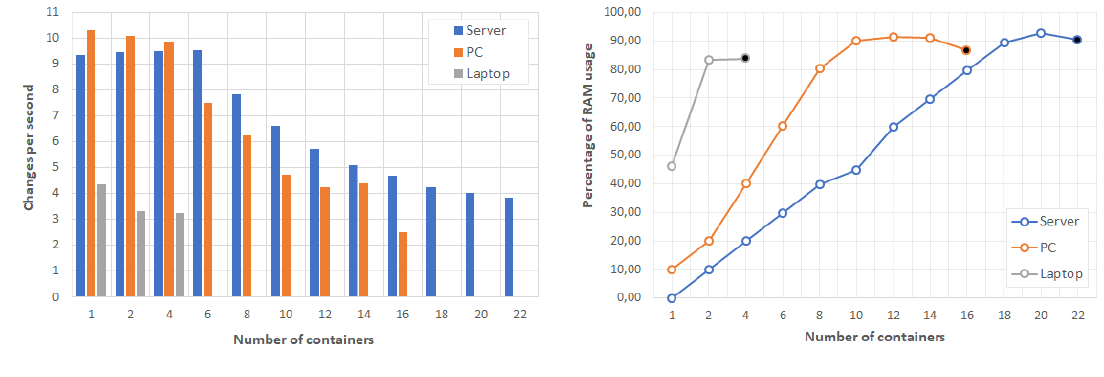
Figure 6. Performance results for Computational Physics simulation in Docker